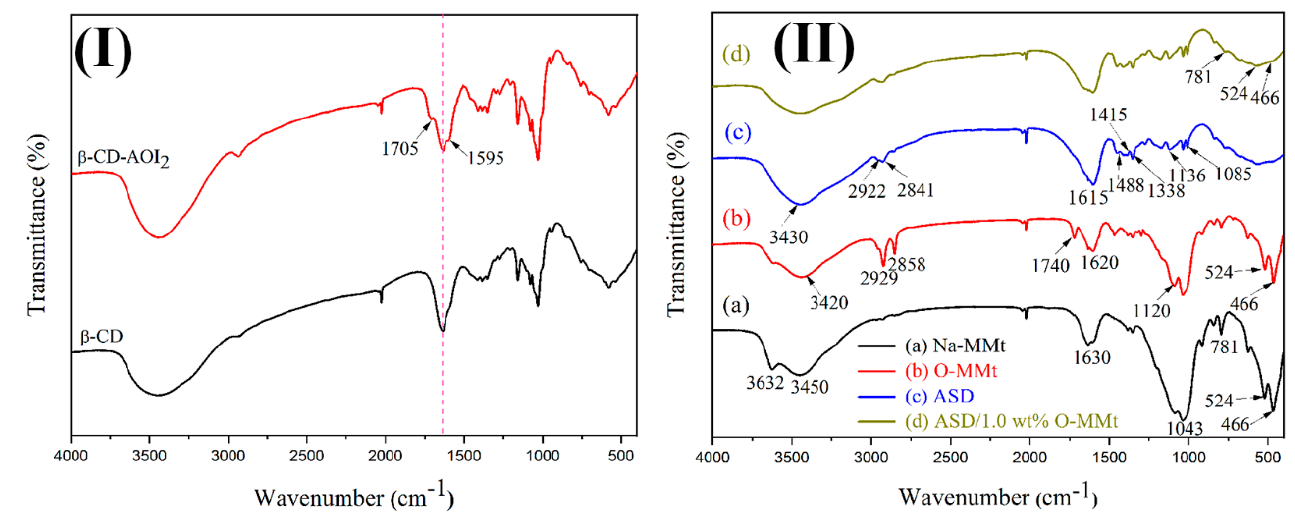
Figure 4. FTIR spectra of ( I ) β − CD and β − CD − AOI 2 and ( II ) ( a ) pristine Na − MMt, ( b ) O − MMt, ( c )